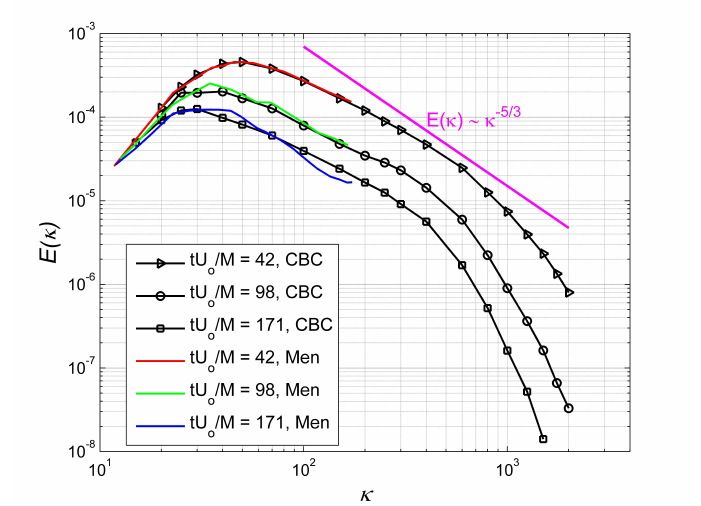
Figure 1. A comparison of the energy spectra obtained by [25] and those using a 32 3 grid with the dynamic Smagorinsky model with Lagrangian-averaging by [26] ( Men in the graph). κ is the wave number related to an eddy’s length scale and E ( κ ) is the eddy’s